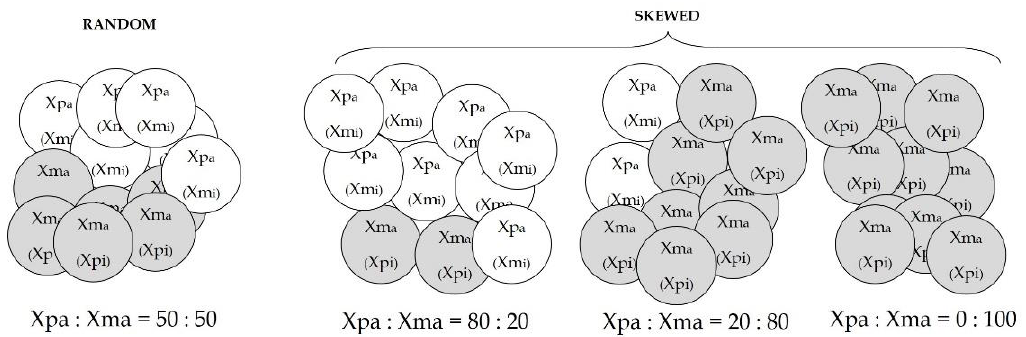
Figure 1. Pattern of XCI in healthy females. Each tissue of females is a mosaic of cells, including cells (white circle) in which the paternal X chromosome is activated (Xpa) and the maternal X chromosome is inactivated (Xmi) and cells (grey circle) in which the maternal X chromosome is activated (Xma) and the paternal X chromosome is inactivated (Xpi).